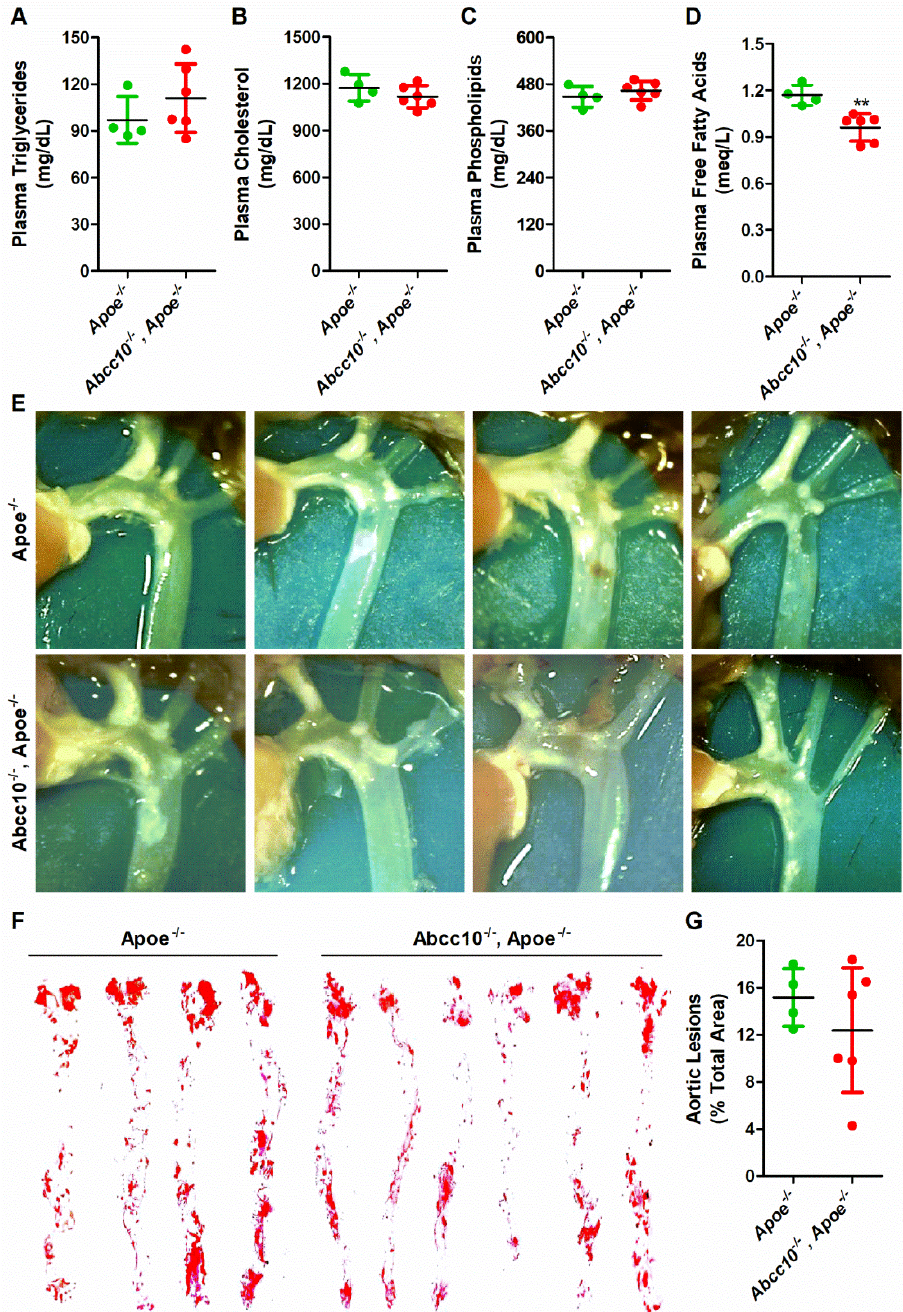
Figure 10. Ablation of ABCC10 in Apoe − / − mice does not enhance atherosclerosis. Age-matched Apoe − / − mice ( n = 4) and Abcc10 − / − , Apoe − / − ( n = 6) were fed Western-type diet for 12 weeks. At the end of the experiment, mice were fasted overnight and blood was collected to isolate plasma. Total triglycerides ( A ), cholesterol ( B ), phospholipids ( C ), and free fatty acids ( D ) were measured. Aortic arch and other proximal arteries were dissected and photographed. Representative photographs from each group are shown ( E ). Aortas were isolated, stained with Oil Red O ( F ), and quantified ( G ). Values are plotted as replicates (mean ± SD). ** p < 0.01 as compared with Apoe − / − mice.